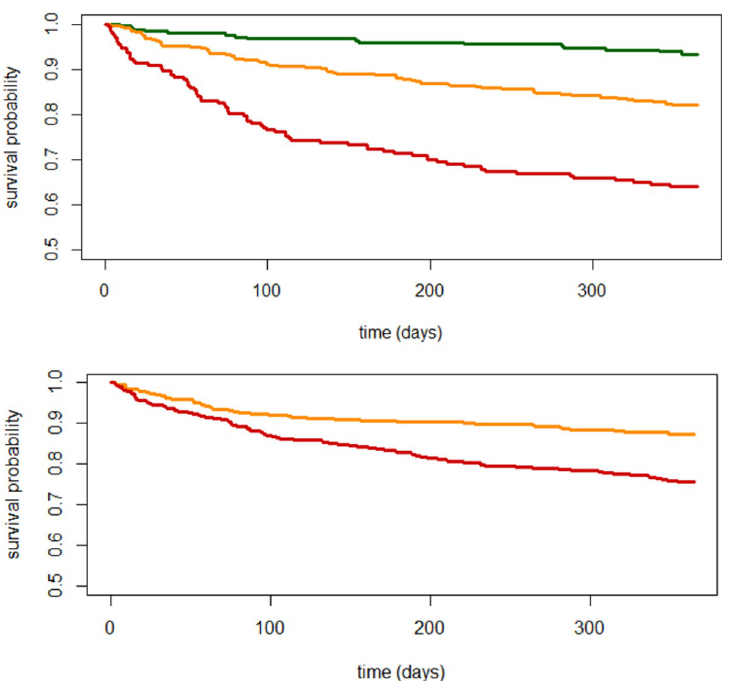
Fig 1. A. Kaplan-Meier curves in three risk groups to visually assess separation (low risk: 0–5 points (green), moderate risk: 6–10 points (orange), high risk: 11–21 (red)). B. Kaplan-Meier curves of the simplified score in two risk groups to visually assess separation (low risk: 0–7 points (orange), high risk: 8–14 (red)).